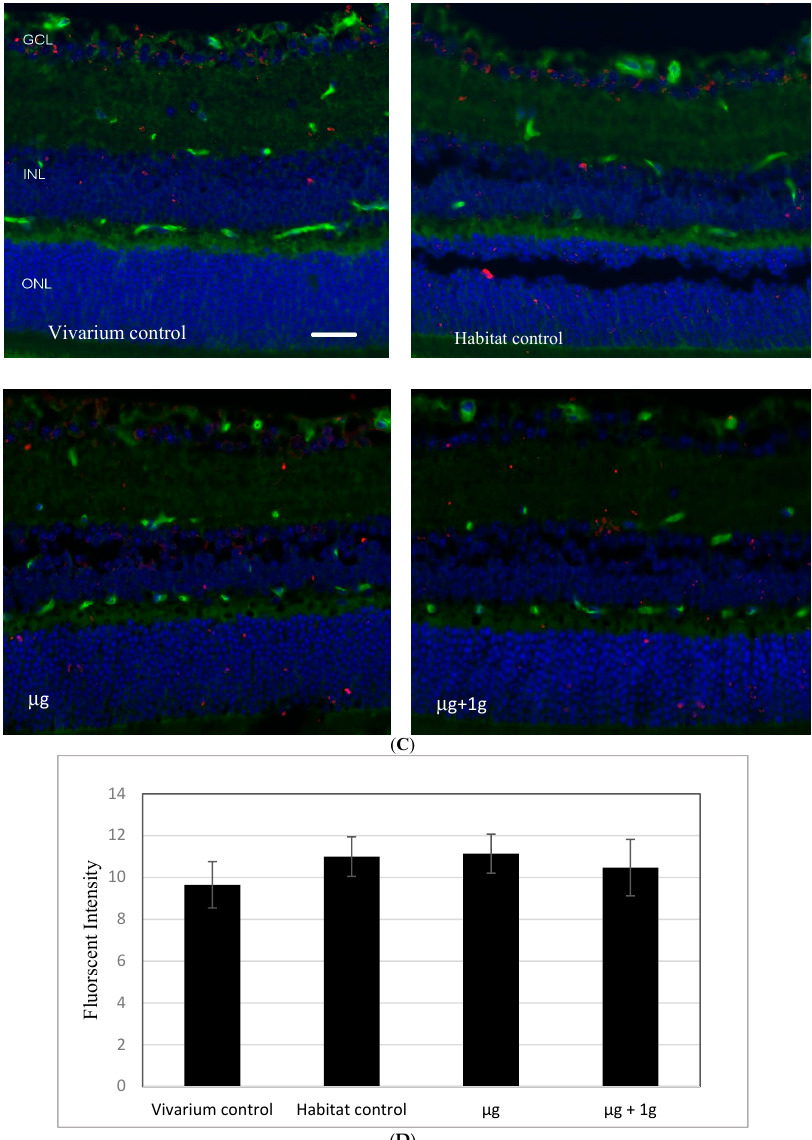
Figure 1. ( A ) Apoptosis based on terminal deoxynucleotidyltransferase dUTP nick-end labeling (TUNEL) staining of 9-week old male C57BL/6 mouse retinal tissue. Groups ( n = 6): Vivarium control, habitat control, µ g, and µ g + 1 g . TUNEL-positive cells were identified with green fluorescence, the endothelium was stained with lectin (red). The nuclei of photoreceptors were counterstained with DAPI (blue). In the control retinal tissue, only sparse TUNEL-positive cells were found. In the retina from µ g mice, TUNEL-positive labeling was apparent in the retinal endothelial cells. Arrow: TUNEL-positive endothelial cell. Outer nuclear layer (ONL); inner nuclear layer (INL); ganglion cell layer (GCL). Scale bar = 50 µ m; ( B ) immunoreactivity of TUNEL staining in the retinal endothelium. Values are represented as mean density ± standard error of the mean (SEM) for a 6 mice/group, and the density profiles were expressed as mean number of apoptotic positive cells/mm 2 . The mean of the density profile measurements across 5 retina sections per eye was used as a single experimental value. a significantly higher than all other groups ( p < 0.05); ( C ) immunoreactivity of 4-HNE staining in the 9-week old male C57BL/6 mouse retina. 4-HNE positive staining was identified with red fluorescence; the nuclei were counterstained with 4 (cid:48) ,6-diamidino-2-phenylindole (DAPI, blue). The vessel was stained with tomato lectin (green). Scale bar = 50 µ m; ( D ) the averages fluorescence intensity for 4-HNE activity were measured and calculated using the ImageJ program. Fluorescence was averaged across 5 retinas per group. Values are represented with mean + SEM. No significant differences among groups were